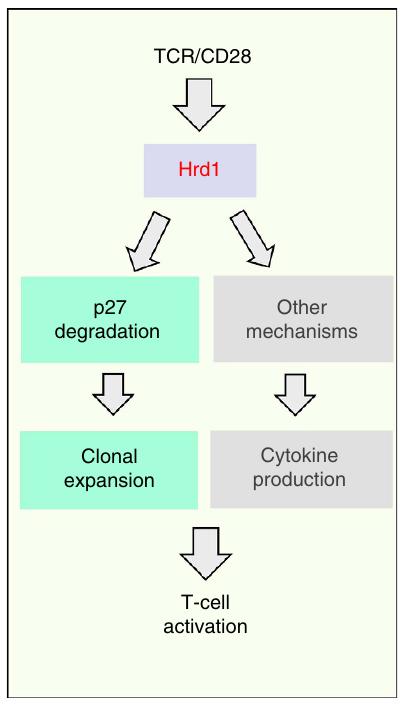
Figure 8 | A proposed model for Hrd1 in T-cell activation. Hrd1 promotes T-cell clonal expansion through p27 degradation and regulates T-cell cytokine production through a molecular mechanism to be